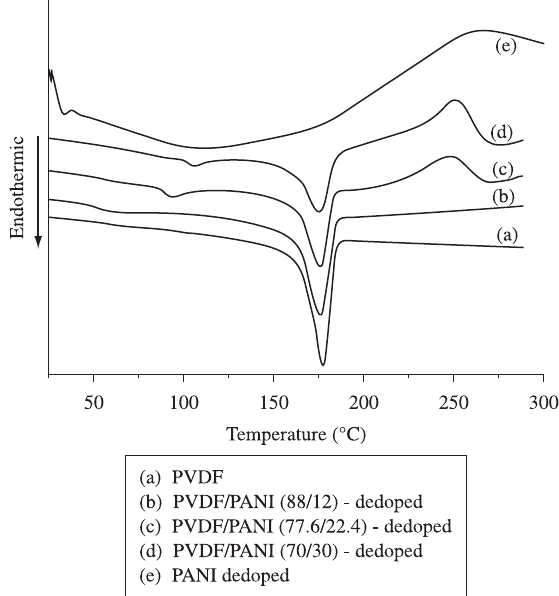
Figure 6. DSC thermograms of: a) PVDF; b) PVDF/PANI (12 wt. (%) PANI); c) PVDF/PANI (22,4 wt. (%) PANI); d) PVDF/PANI (30 wt. (%) PANI); and e) PANI. The PANI and blends are dedoped.